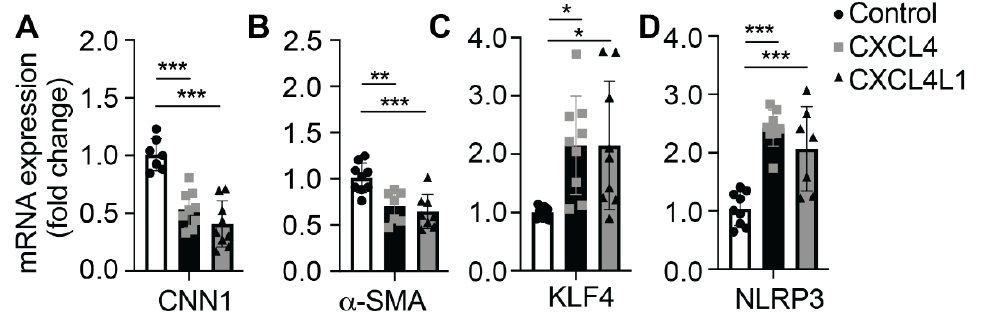
Figure 4. Expression of mRNA by quantitative real ‐ time PCR. Primary VSMCs were cultured at 120,000 cells/well in Dulbecco’s modified Eagle medium (DMEM) with 20% FBS prior to treatment with or without CXCL4 or CXCL4L1 at 1 μ g/mL in DMEM with 2.5% FBS for 24 h. Relative gene expression was expressed as fold change of ( A ) calponin (CNN1), ( B ) α‐ smooth muscle actin ( α‐ SMA), ( C ) KLF4, ( D ) NLRP3. * p < 0.05, ** p < 0.01, *** p < 0.001, n = 7–9 independent experiments, one ‐ way ANOVA with Dunnett’s post ‐ test.